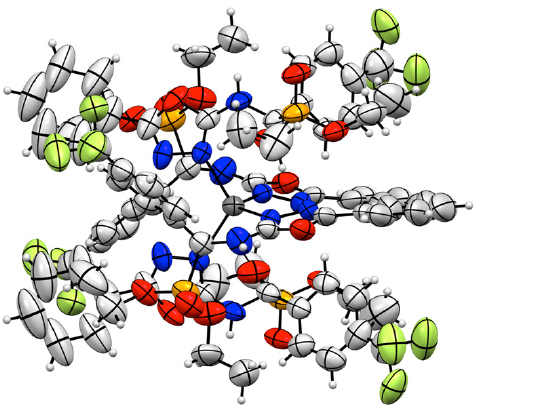
Figure 4. ORTEP drawing of complex 3 , 50 % probability thermal ellipsoids (BF 4 and solvent mol ‐ ecules are not visible). Important bond lengths (Å) and angles (°): Ag1 ‐ N1 2.289(4), Ag1 ‐